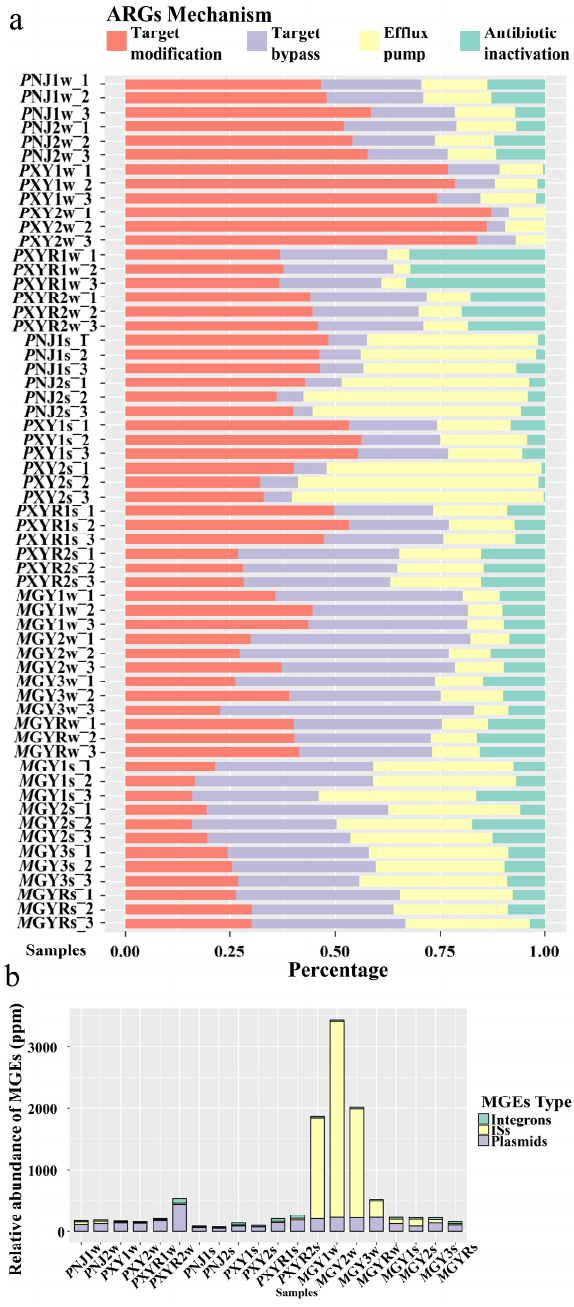
Figure 4. ( a ) Relative abundance of different resistance mechanisms of ARGs in all environmental samples collected in P. clarkii and M. rosenbergii aquaculture environments. ( b ) Relative abundance of MGEs in water and sediment samples.